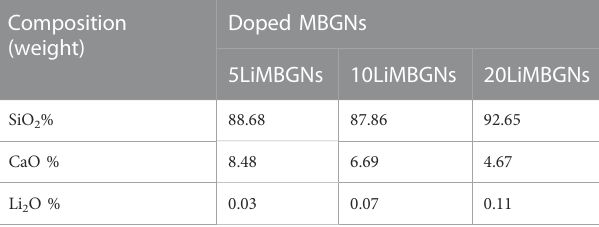
TABLE 2 Composition by weight percentage of the Li doped MBGNs according to ICP-OES. Composition